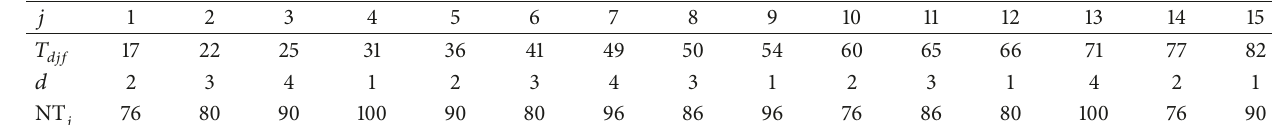
Table 3: Formation scheme of 15 container trains.